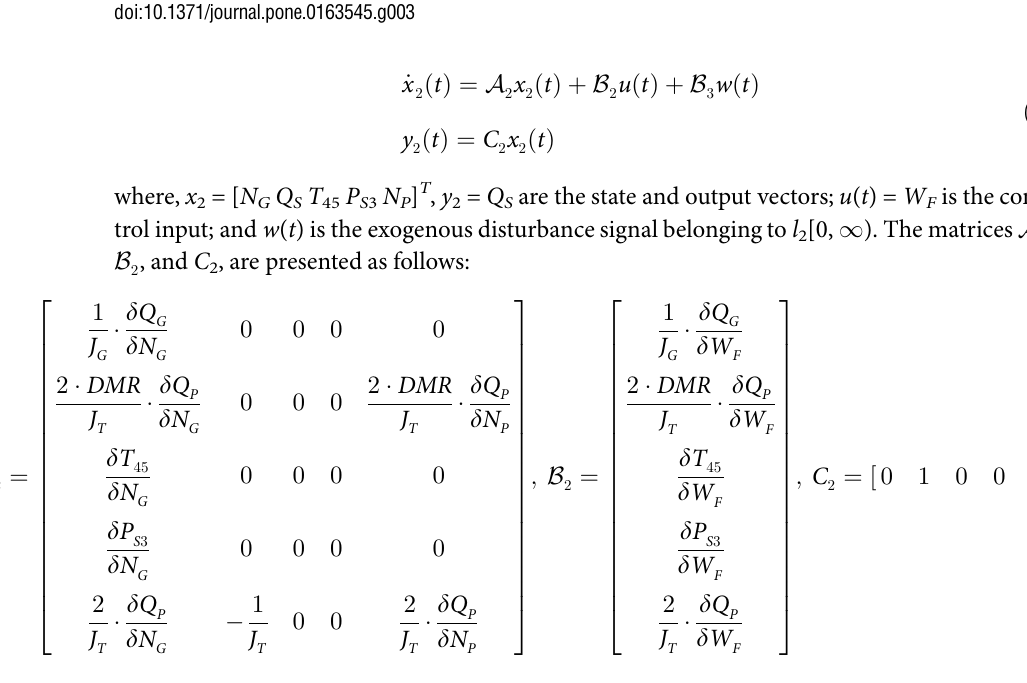
Fig 3. Block diagram of the simplified linearized gas generator and rotor